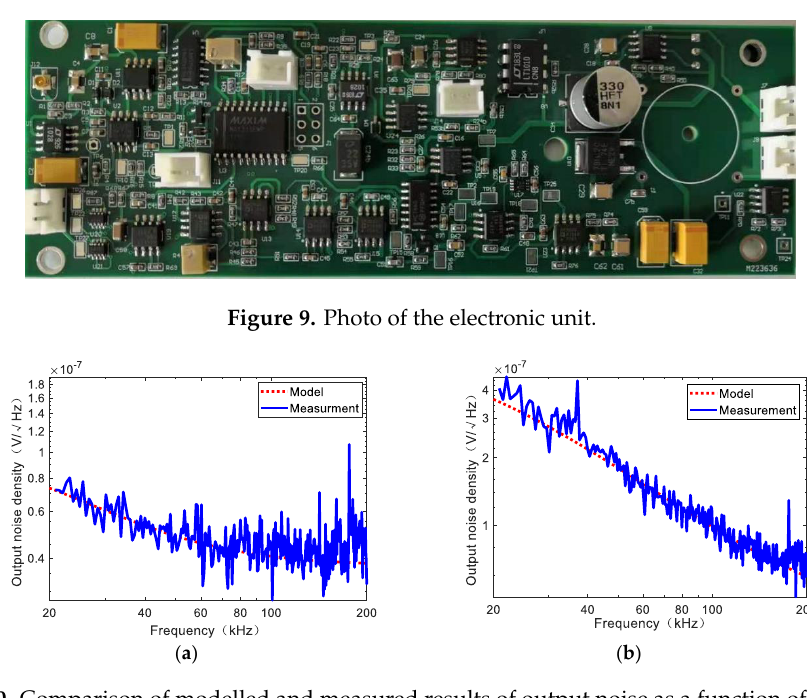
Figure 10. Comparison of modelled and measured results of output noise as a function of frequency. ( a ) Output noise without incident light. ( b ) Output noise with incident light.